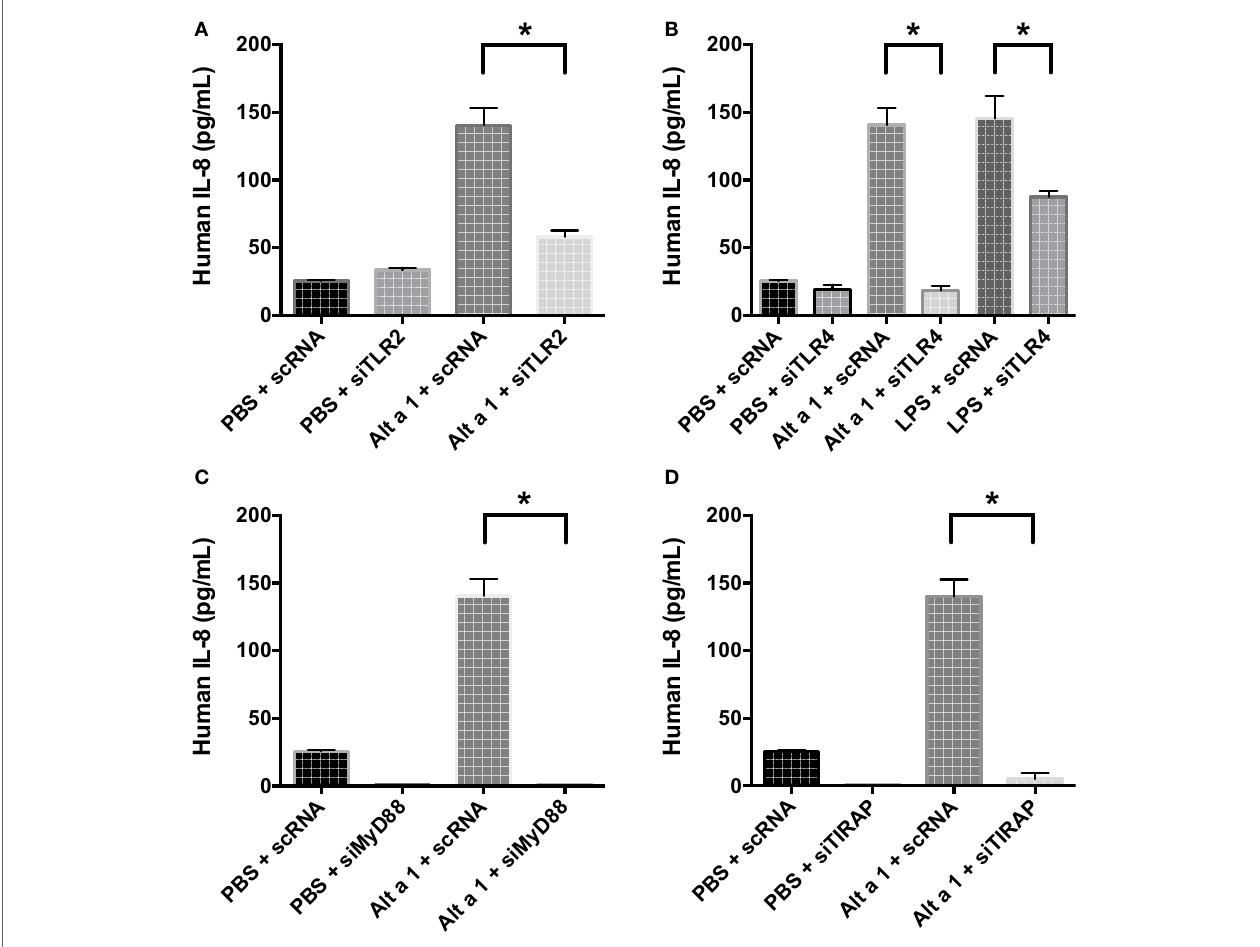
FigUre 4 | Alt a 1 induces signaling in BEAS-2B cells via toll-like receptor (TLR)2, TLR4, MyD88, and TIRAP. 3.0 × 10 4 human BEAS-2B cells in DMEM + 10% FBS were cultured to 70% confluency in 24-well plates. The cells were transfected with 10 nM of either scrambled control or gene-specific siRNAs in serum-free Opti-MEM medium using Lipofectamine RNA iMAX Reagent according to the manufacturer’s protocols. After 24 h, cells were treated with either 50 µg rAlt a 1 or an equivalent volume of PBS. Media was collected and assayed via BIOLEGEND IL-8 ELISAMAX. Data are represented as mean (SD). After testing for homogeneity of variances, Tukey’s HSD was performed and adjusted (if applicable) (* p < 0.001). (a) TLR2, (B) TLR4, (c) MyD88, and (D)